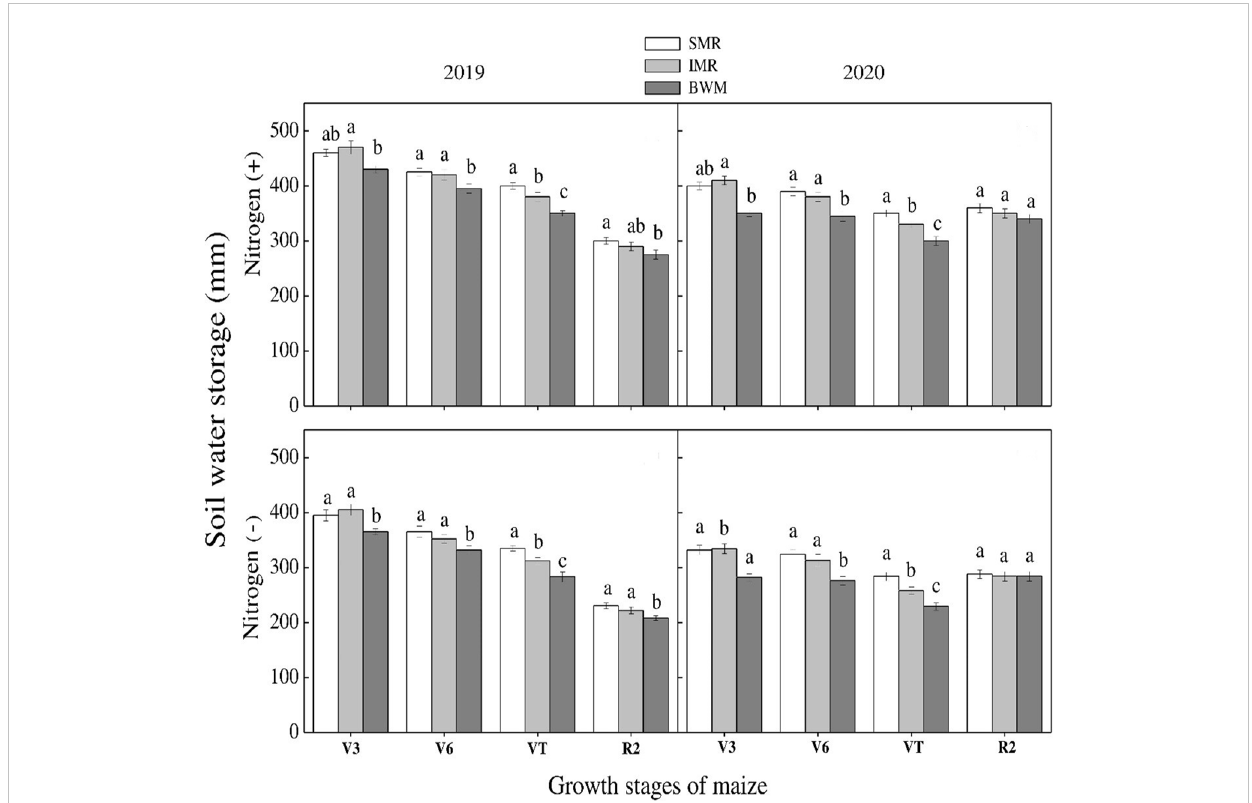
FIGURE 11 Soil water storage under sole maize row (SMR), intercropped maize row (IMR) and the rows between the intercropped strips of both crops at various growth stages under with and without N application. Different letters on the top of each bar indicate signi fi cant differences among the various crop growth stages of maize, as calculated by Tukey ’ s HSD test at P ≤